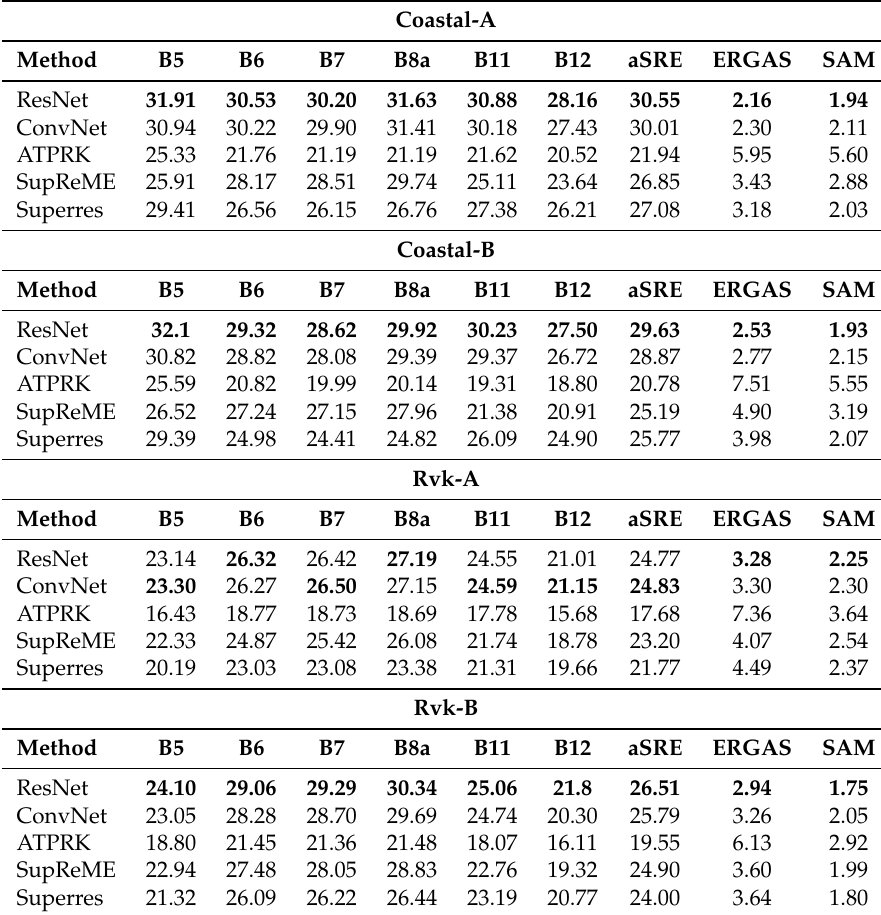
Table 1. Quantitative evaluation results for all datasets and all methods. The data have been degraded two-fold in resolution in order to use the observed 20 m bands as the reference image. Columns B5 to B12 are the band-wise SRE values, while aSRE is the average SRE of the bands and is given in dB. SAM is given in degrees. Bold typeface indicates the best